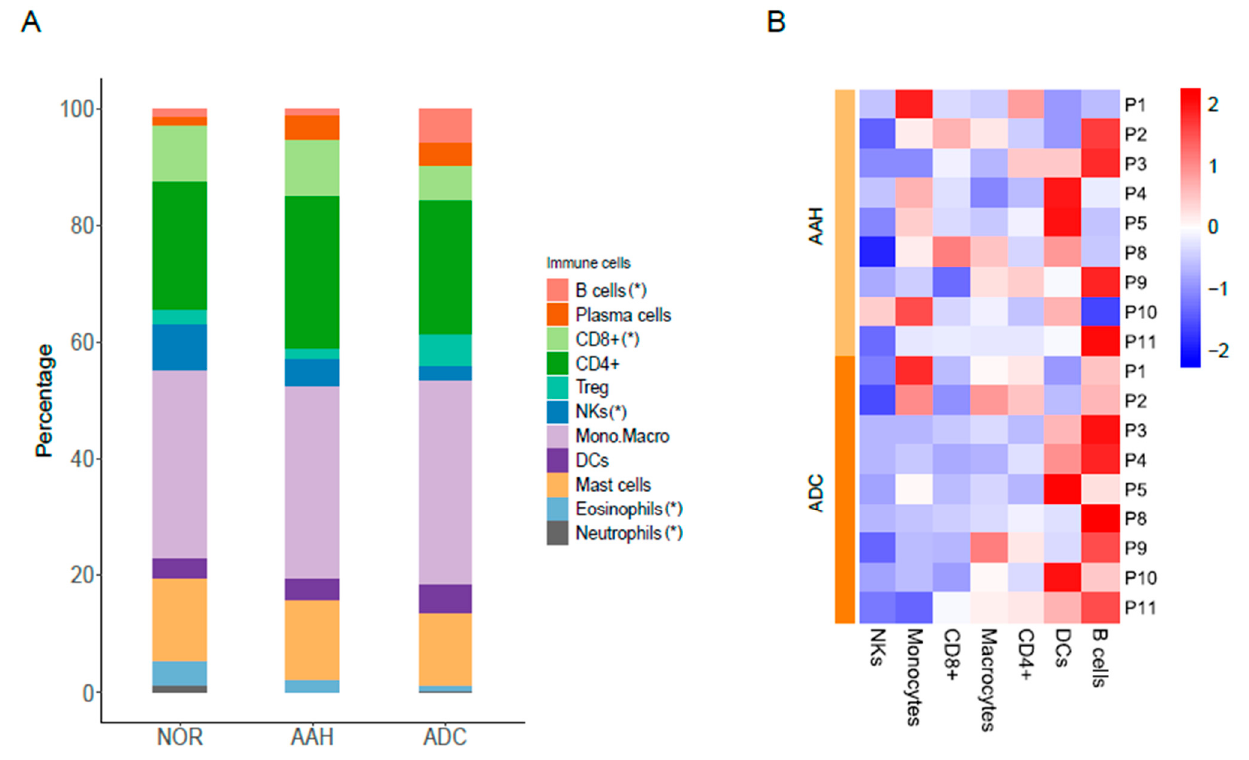
Figure 3. Immune cell signatures across different tissues and patients. ( A ) Proportion of immune cells in normal tissues, AAH, and ADC tissues. (*) indicates the significance test results ( p -value < 0.05) in paired t -test of B cells (ADC vs. NOR), CD8+ (ADC vs. NOR), NKs (AAH vs. NOR, ADC vs. NOR, ADC vs. AAH), eosinophils (AAH vs. NOR, ADC vs. NOR, ADC vs. AAH) and neutrophils (AAH vs. NOR, ADC vs. NOR). ( B ) Relative differences expressed in z-score in tumor lesions compared to normal samples. AAH, atypical adenomatous hyperplasia; ADC, adenocarcinoma; NOR, normal.